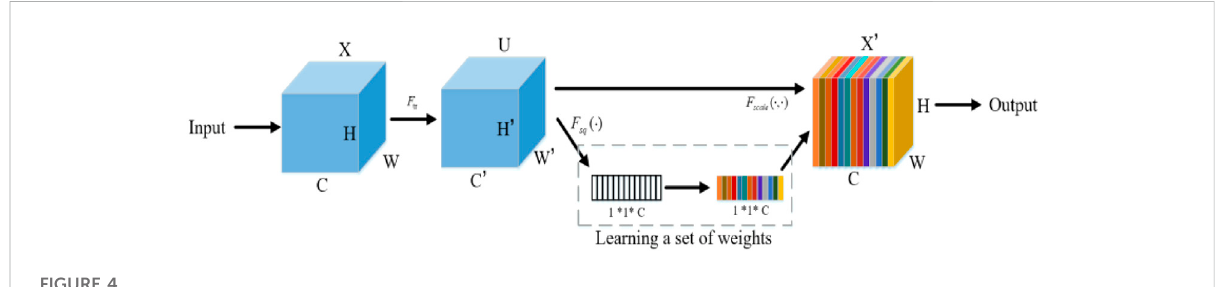
FIGURE 4 SENet network structure.